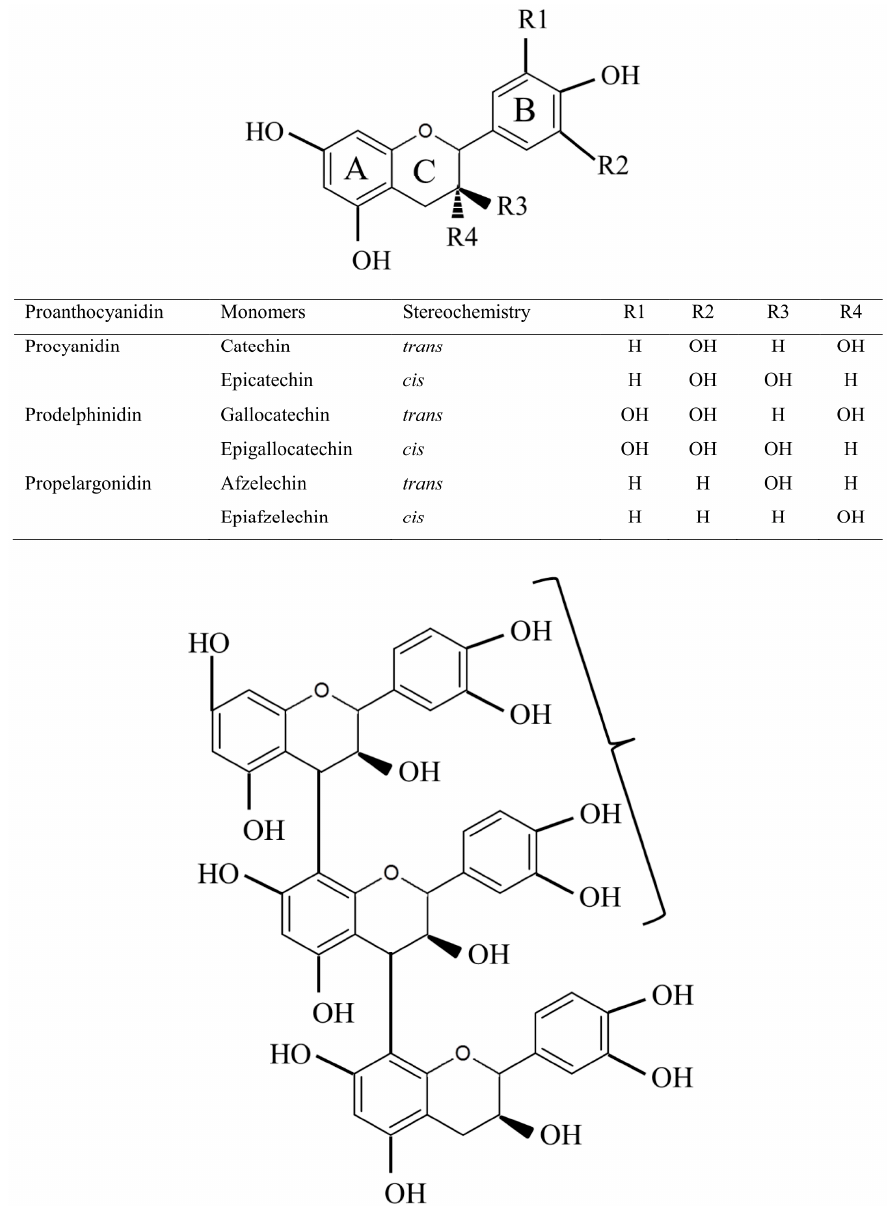
Figure 2. Structure of (epi)-flavan-3-ol and substitution patterns of proanthocyanidins found in legumes.